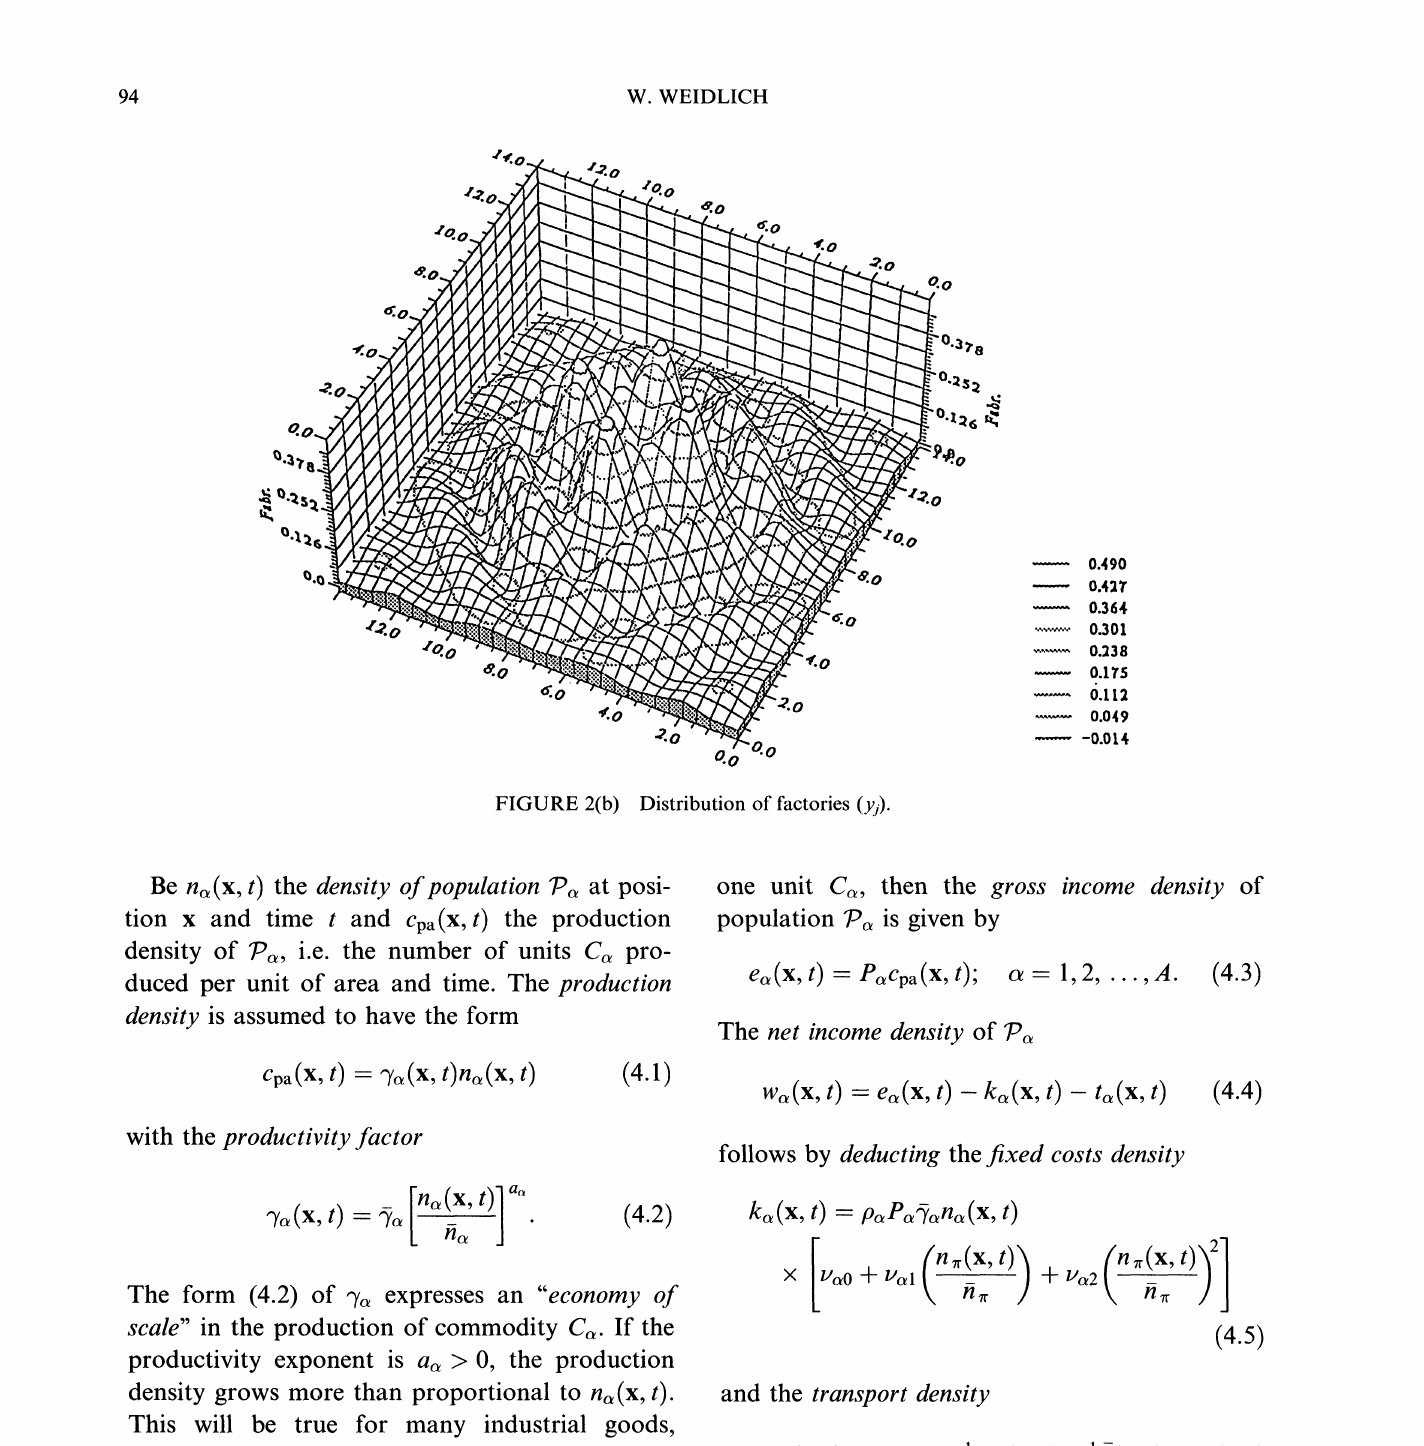
FIGURE 2(b) Distribution of factories